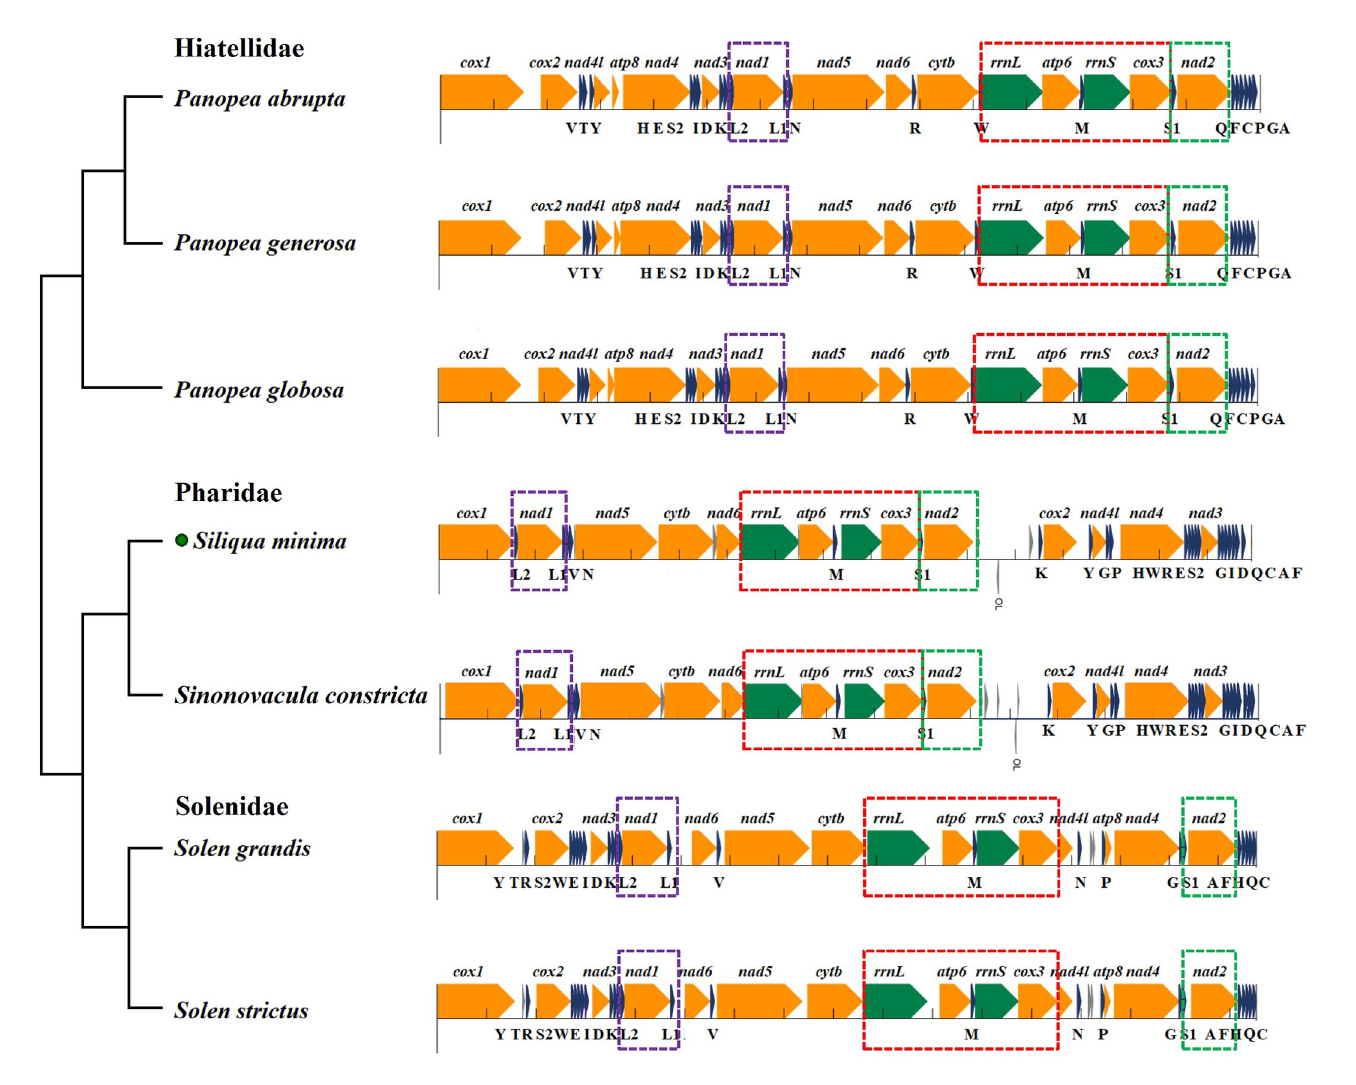
Fig 7. Comparison of mitochondrial gene rearrangements of the order Adapedonta. Gene segments are drawn to scale. Protein-coding, rRNA, and tRNA genes are shown in orange, green, and dark blue, respectively. Genes are oriented either to the right or to the left depending on whether they are encoded on the light or heavy strand. The dotted boxes in purple, red, and green represent fragments A, B, and C with the same gene order, respectively.